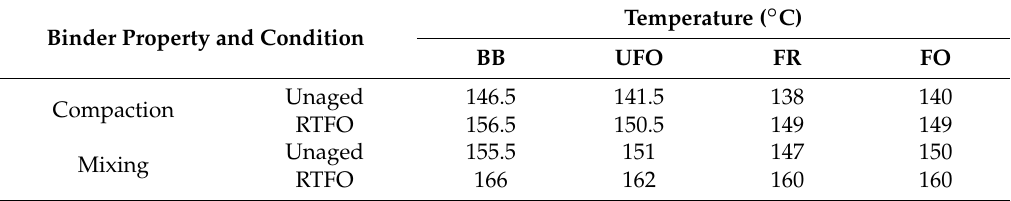
Table 7. Compaction and mixing temperature changes with engine oil